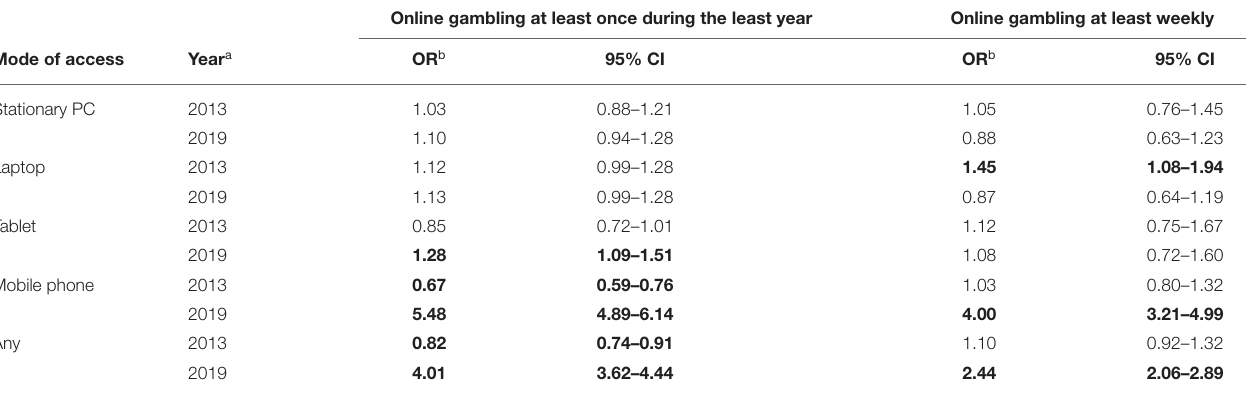
TABLE 2 | Odds ratios for online gambling at least once during the last year and at least weekly by mode of Internet access among gamblers. Online gambling at least once during the least year Online gambling at least